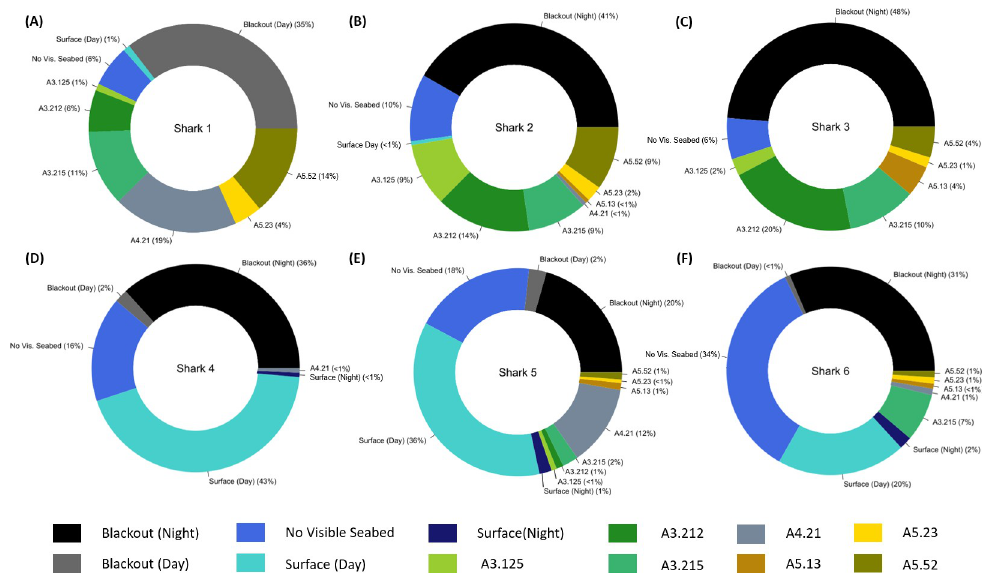
Fig 4. Habitat association by basking sharks. Proportion of time sharks 1–6 ( A to F ) spent swimming over different habitat types characterised by their European Nature Information System (EUNIS) code (A3.125 mixed kelp with opportunistic red seaweed on sand-covered infralittoral rock, A3.212 Laminaria hyperborea on tide-swept infralittoral rock, A3.215 Dense foliose red seaweeds on silty moderately exposed infralittoral rock, A4.21 Echinoderms and crustose communities on circalittoral rock, A5.13 Infralittoral coarse sediment, A5.23 Infralittoral fine sand, A5.52 Kelp and seaweed communities on sublittoral sediment). Includes proportion of time sharks spent in the water column (No Vis. Seabed), or when habitat could not be characterised owing to poor light conditions from deep diving (Blackout Day) or recording at night (Blackout Night).